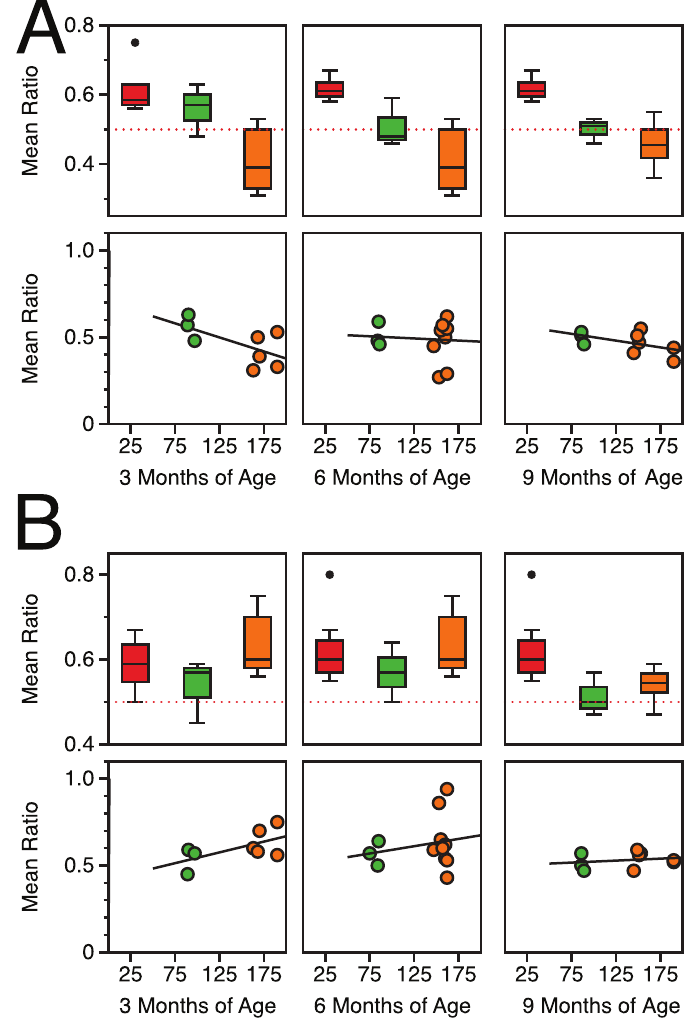
Figure 2. Spatial processing deficits in CGG KI mice scale with CGG repeat length and age. A . Metric/Coordinate task by repeat length and age. B . Topological/Categorical task by repeat length and age. The red line signifies no response from the animal to spatial change. Data replotted from Hunsaker et al. , 2009, 2012 41,44